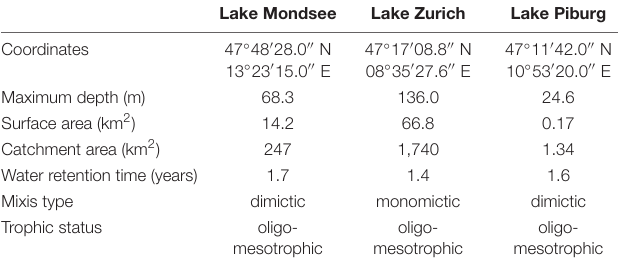
TABLE 1 | Characteristics of the study sites (e.g., Bossard et al., 2001; Dokulil et al., 2006; Sonntag et al., 2011; Ficker et al., 2017; Yankova et al., 2017; Niedrist et al.,